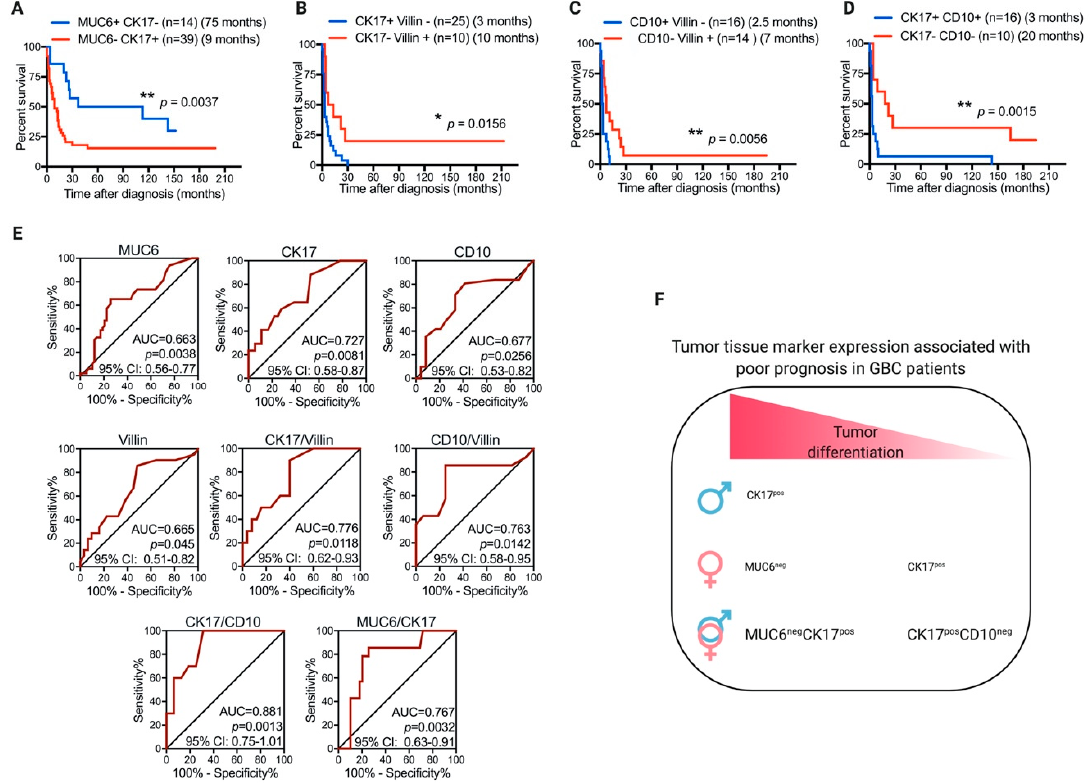
Figure 3. Tumor expression patterns MUC6 + CK17 – and CK17 + CD10 – associated with better and worse prognoses of GBC patients, respectively. Kaplan–Meier postdiagnosis overall-survival (OS) estimation of GBC patients according to tumor expression pattern for ( A ) MUC6/CK17 in well- to moderately differentiated tumors, ( B ) CK17/Villin, ( C ) CD10/Villin, and ( D ) CK17/CD10 in poorly differentiated tumors. Each graph shows the number of patients included in each group ( n ) and median OS time in months. ( E ) Receiver-operating-characteristic (ROC) curves for patient survival according to tumor-marker pattern expressions. AUC: area under the curve. CI: confidence interval. ( F ) Association of tumor-marker expression and poor prognosis of GBC according to patient tumor differentiation status and gender. Font size indicative of statistical significance.